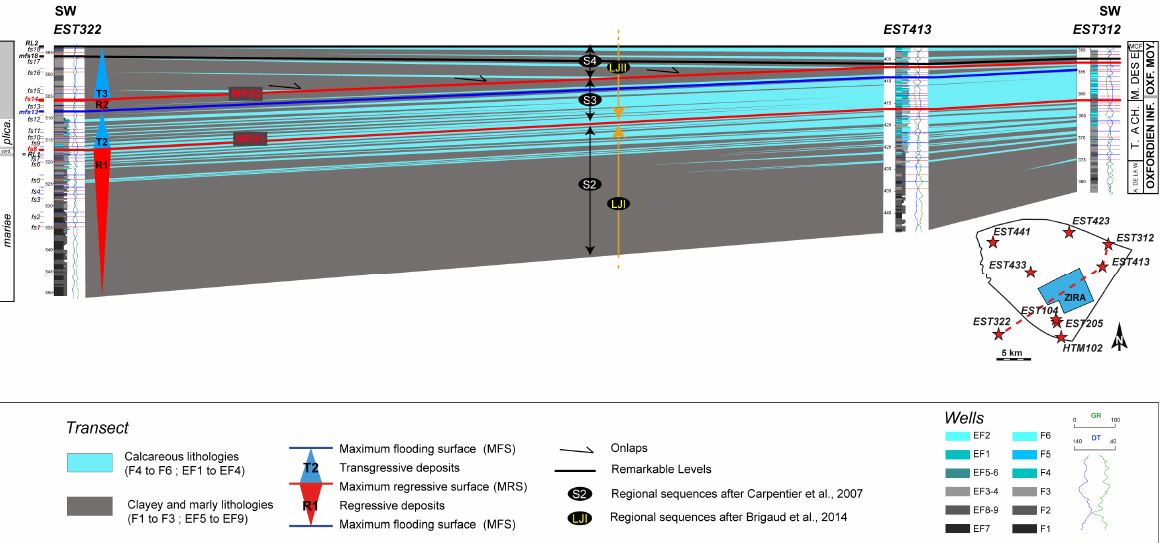
Figure 9. Correlations on an NE-SW transect (wells EST322 – EST413 – EST312) showing lithological evolution and transgression/regression cycles. Litho and electrofacies have been grouped into calcareous deposits (from nodular marlstone to massive limestone in blue) and clayey deposits (clays, silty calcareous clays and bioclastic marlstone in grey). Wells have been horizontalised on surface RL2.